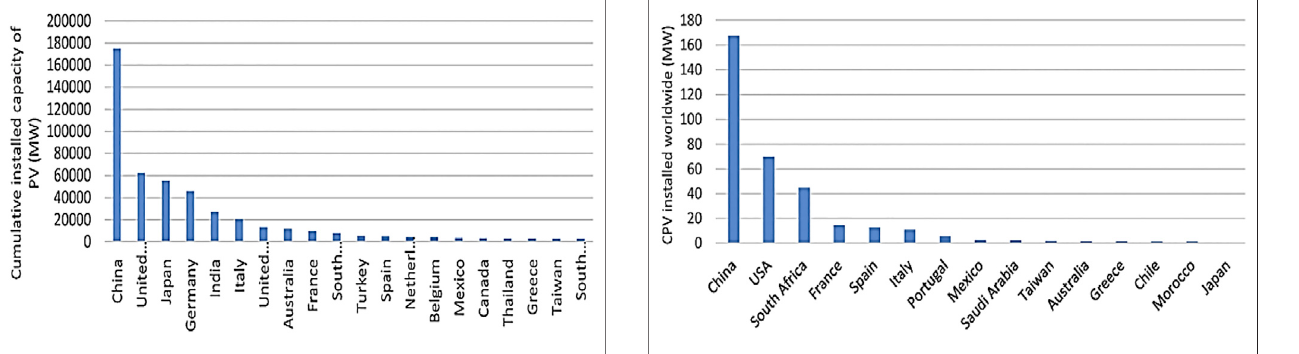
FIGURE 2 | Installed capacity of PV (MW) (Zineb et al., 2021). FIGURE 3 | Total Installed CPV worldwide (Zineb et al.,